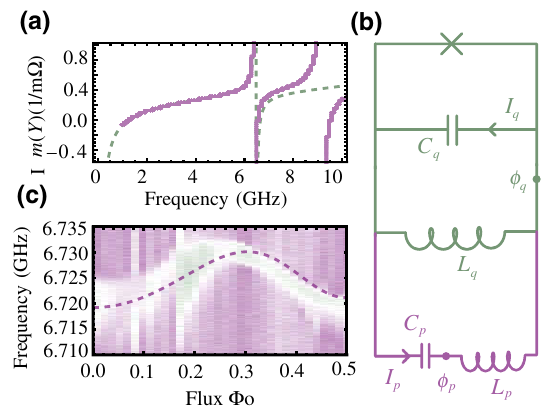
FIG. 6. The qubit parasitic mode. (a) The simulated admit- tance of the coil used in qubits E and F. The purple dots represent the simulation, while the green dashed line is a fit to the circuit shown in (b). The fitted parameters are C q = 4.8 fF, L q = 530 nH, C p = 0.47 fF, and L p = 1.3 μ H. The simulated data show an additional pole appearing at higher frequency that was not identi- fied in the qubit spectrum. (b) A phenomenological circuit model for the high-frequency response of the coil inductor that shows very good agreement with the simulated admittance up around 8 GHz. The green part of the circuit represents the qubit, while the purple part models the parasitic mode. (c) The two-tone spec- troscopy data of the parasitic mode of the qubit. The dashed line is obtained by solving the full Hamiltonian containing the qubit, the resonator mode, and the parasitic mode. Here, the coupling to the parasitic mode is taken to be 0.84 GHz, as correctly predicted by Eq. (B7).